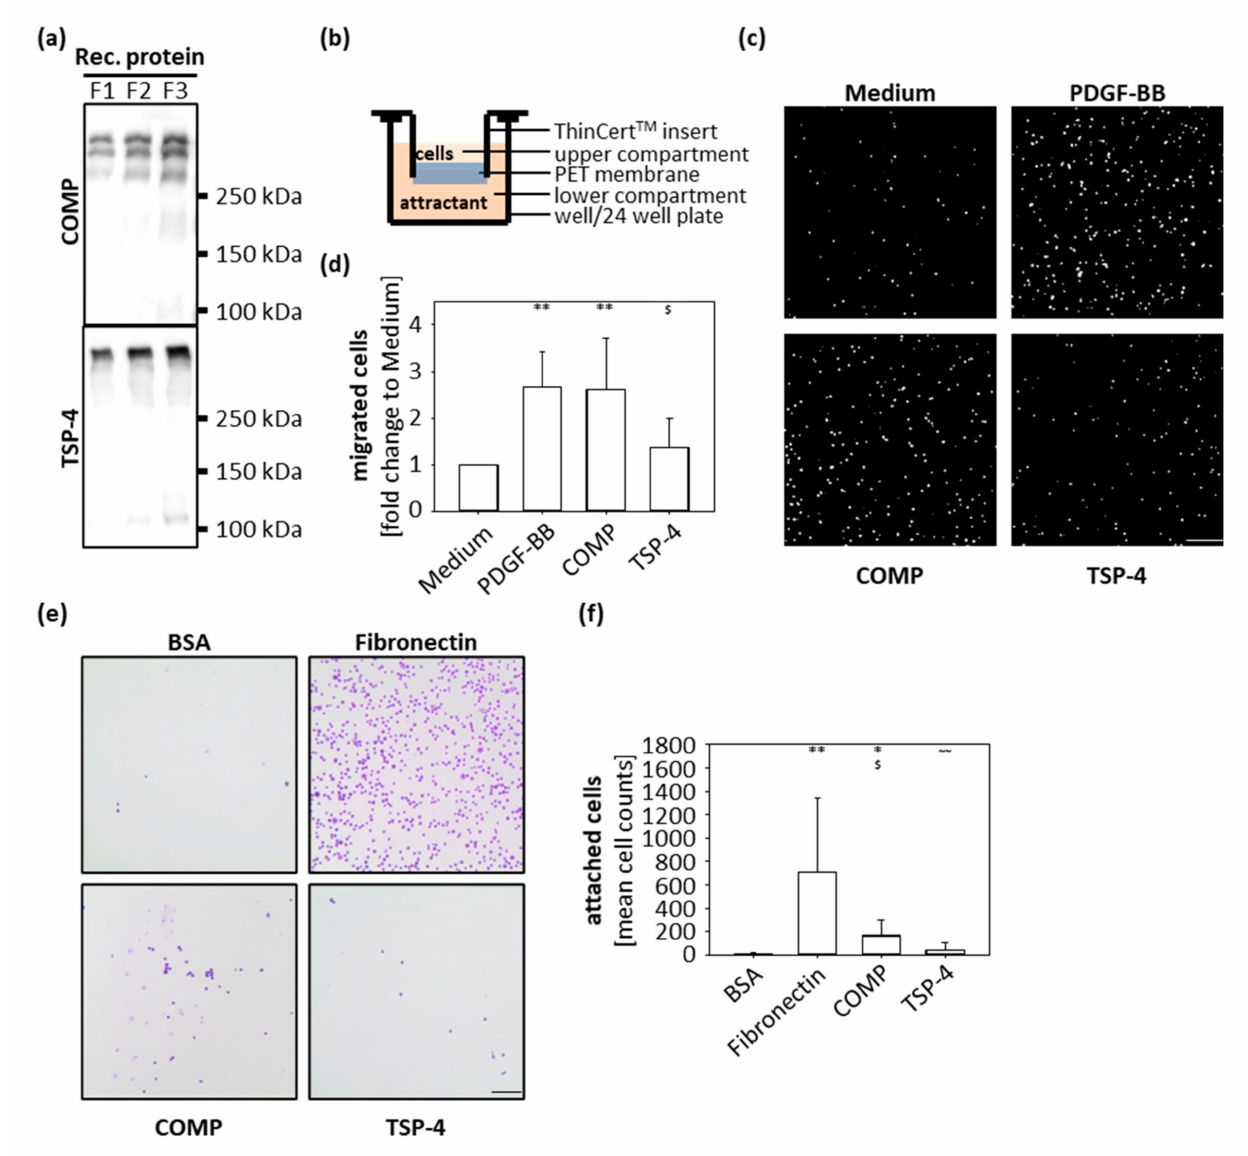
Figure 2. Chondrocyte migration and attachment to COMP and TSP-4. ( a ) Recombinant (rec) COMP and TSP-4 were eluted from the columns in several steps and every protein fraction (F) analyzed by immunoblot. ( b ) Schematic illustration of the transwell system. Porcine chondrocytes were added to the upper compartment and allowed to migrate towards COMP (10 µ g/mL) or TSP-4 (10 µ g/mL) for 10 h. ( c ) Representative images of migrated chondrocytes stained with DAPI. ( d ) Migrated cells were counted and cell numbers statistically evaluated. Each bar shows the mean + SD and significance (to medium: p < 0.01 ** and to PDGF-BB: p < 0.05 $) was analyzed. ( e ) Representative images of attached chondrocytes stained with crystal-violet. ( f ) Attached cells were counted and cell numbers statistically evaluated. Each bar shows the mean + SD and significance (to BSA p < 0.05 *, p < 0.01 **, to fibronectin p < 0.05 $ and COMP p < 0.01 ~~) was analyzed. The standard medium was used as a negative and PDGF-BB (10 ng/mL) as a positive control for the migration assay. BSA (100 mg/mL) was used as a negative control and fibronectin (10 µ g/mL) as a positive control for cell attachment. ( n = 4–5); scale bar = 100 µ